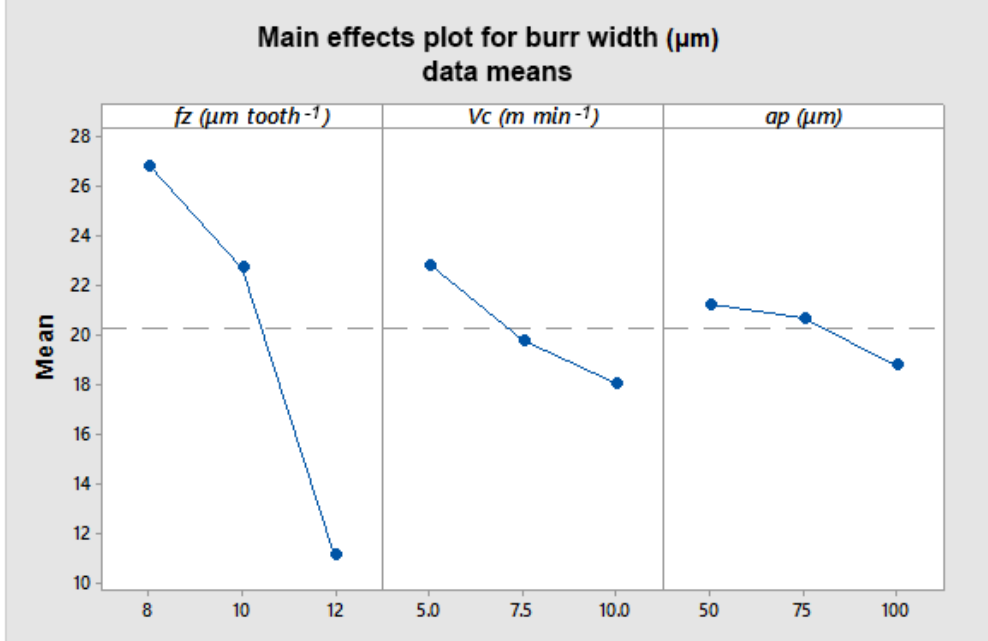
Figure 6. Main effects plots for top burr width with respect to machining parameters (feed, speed and depth of